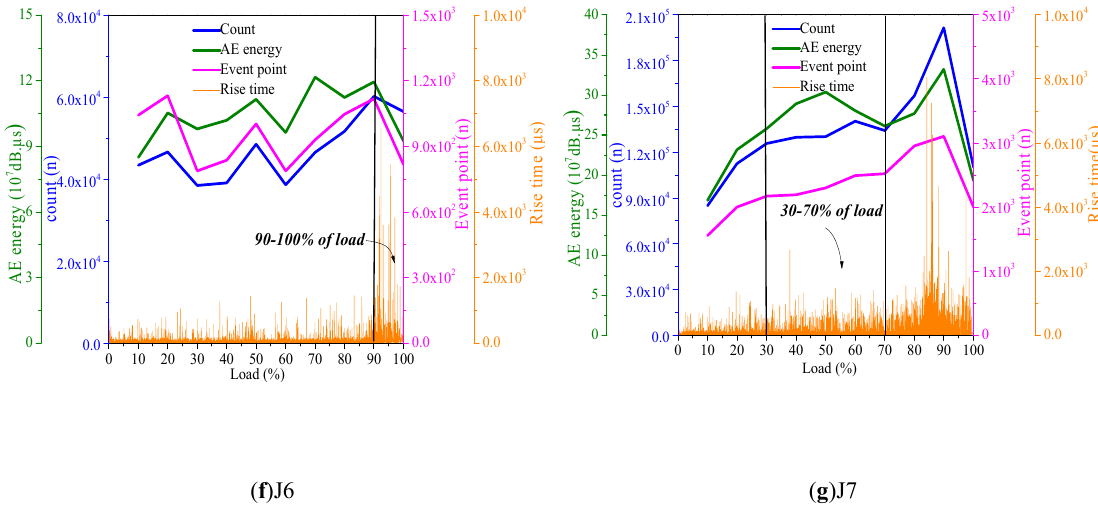
Figure 5. Analysis of AE activity and crack development rate of